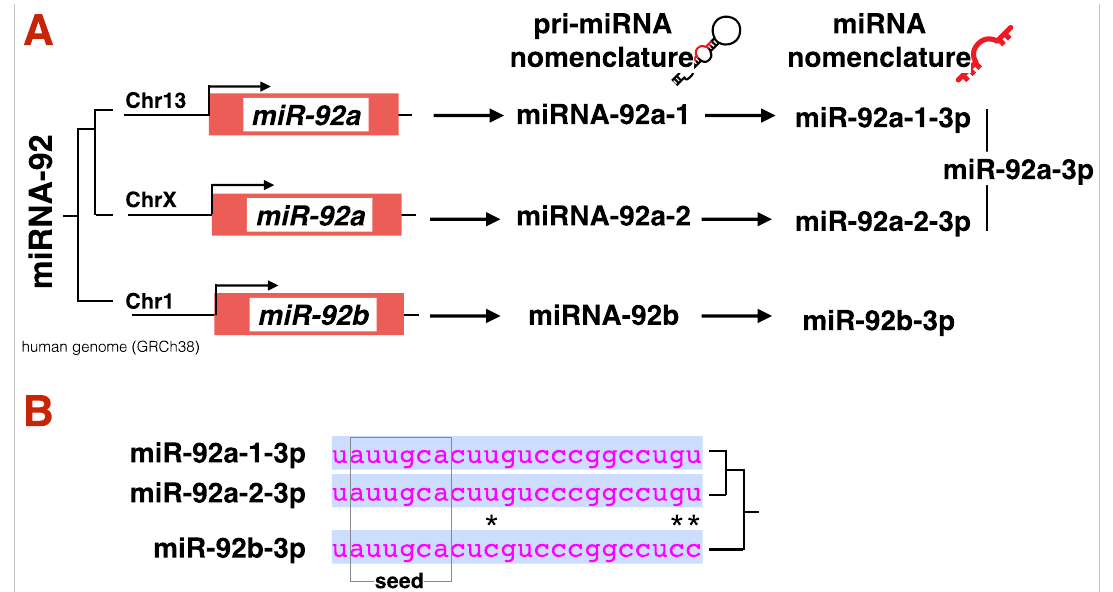
Figure 4. miRNA complete nomenclature . A layer of complexity in the miRNA field is the fact that some miRNA genes have paralogues, thus the same miRNA may arise from two di ff erent location in the genome. When a miRNA is encoded by two or more genes (as in example miR-92), the complete nomenclature should include a number that refer to the locus-of-origin of such miRNA, i.e., miR-92a (which share the same seed sequence with miR-92b, yet they are not identical ( B )), is produced by two genes in humans, in chromosome 12 and chromosome X ( A ). The complete nomenclature for miR-92a thus includes a “-N” to indicate the distinct origin of the pri-miRNA (miR-92a-1 (from Chr 13) and miR-92a-2 (from Chr X)). This system is particularly necessary in experiments where pri-miRNAs are reintroduced in cells using vectors or synthetic RNA, as distinct pri-miRNAs may be processed di ff erently by DICER. However, while the sequence of the pri-miRNA stem-loop between miR-92a-1 and miR-92a-2 is distinct, the resulting mature miRNA is in actuality identical. Although from di ff erent loci, the origin of the mature miR-92a-3p in cells is the result of the transcription of two genes, and only genetic testing with individual gene KO may reveal the contribution of each locus to the final miRNA pool. When we refer to a mature miRNA with district gene origin, we drop the “-N” nomenclature and simply refer to it as miR-92a-3p (A—far right). (*) marks diverse nucleotides between